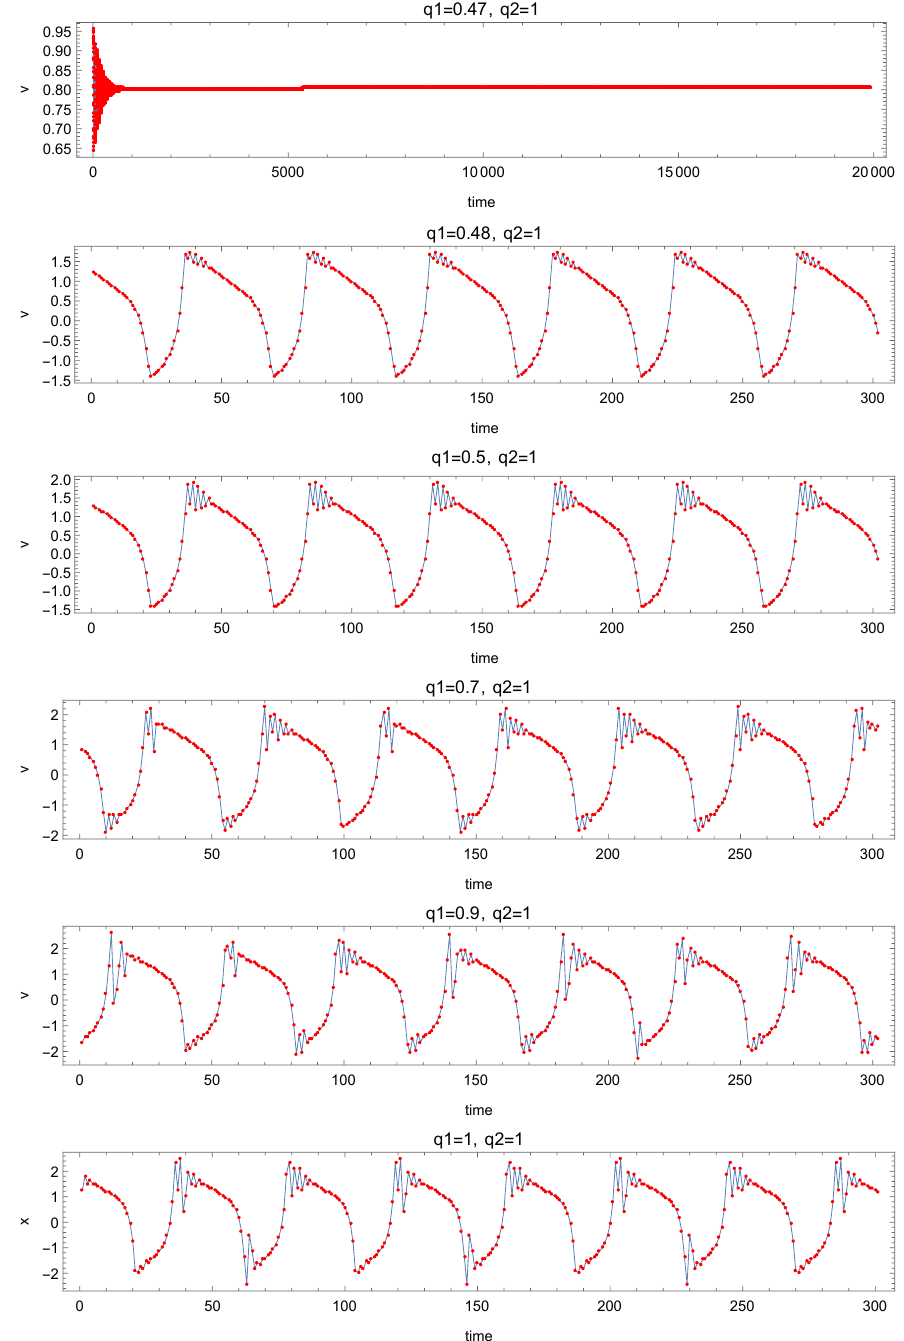
Figure 3. Evolution of membrane potential of system (11), with parameter values r = 0.08, c = 0.7, d = 0.8, and I = 1.25 for different values of the fractional